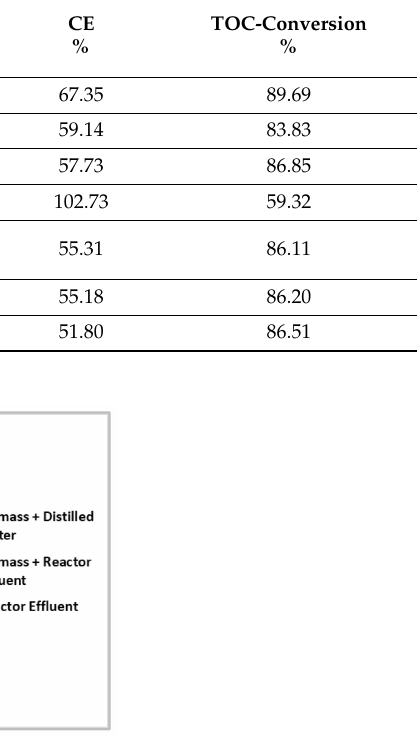
Figure 5. Gas composition of experiments with Reed Canary Grass for three different